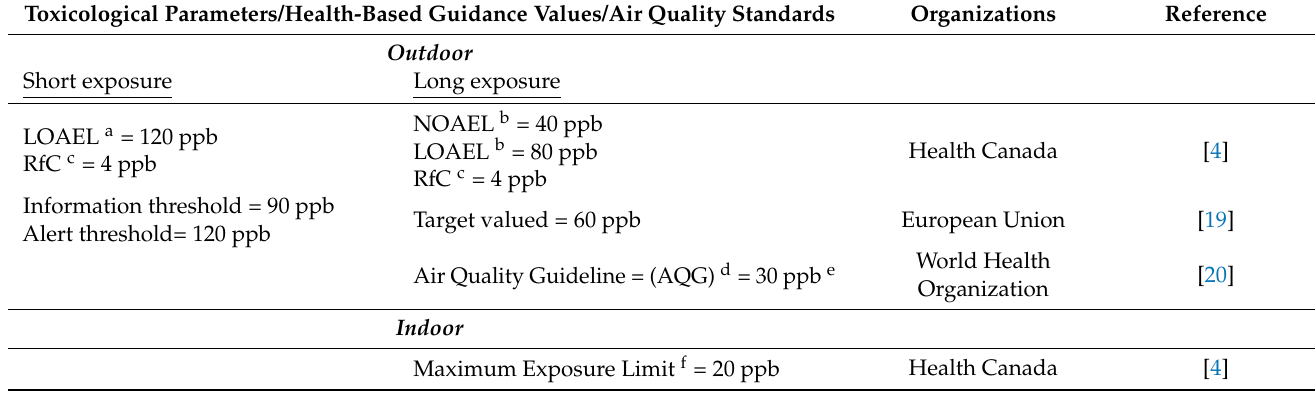
Table 2. Toxicological parameters, health-based guidance values and air quality standards for short and long exposure to outdoor and indoor ozone.